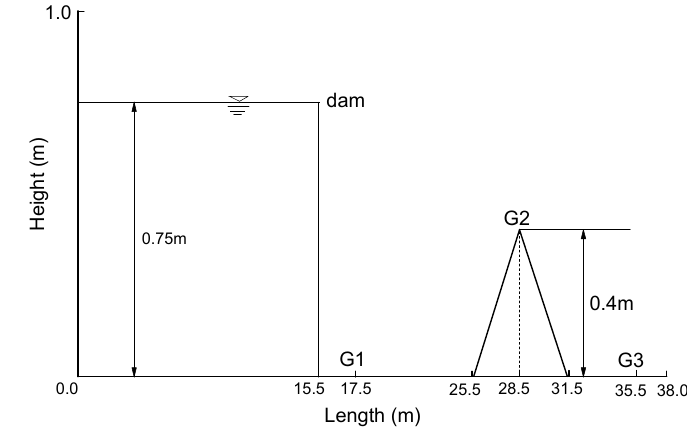
Figure 19. Experimental set-up of a dam-break over a triangular obstacle.